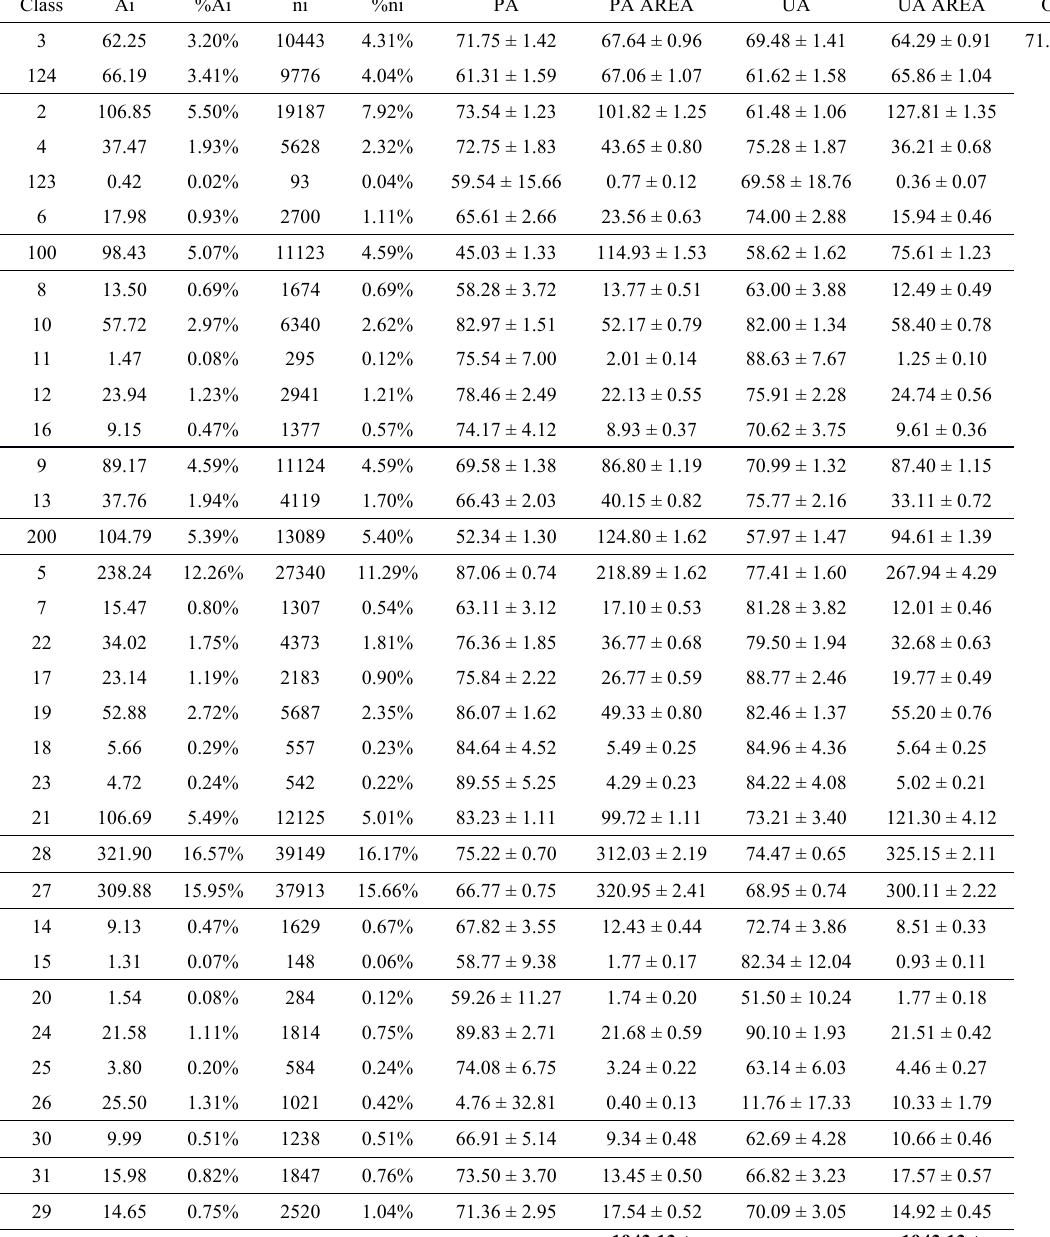
Table 3: Validation results at level